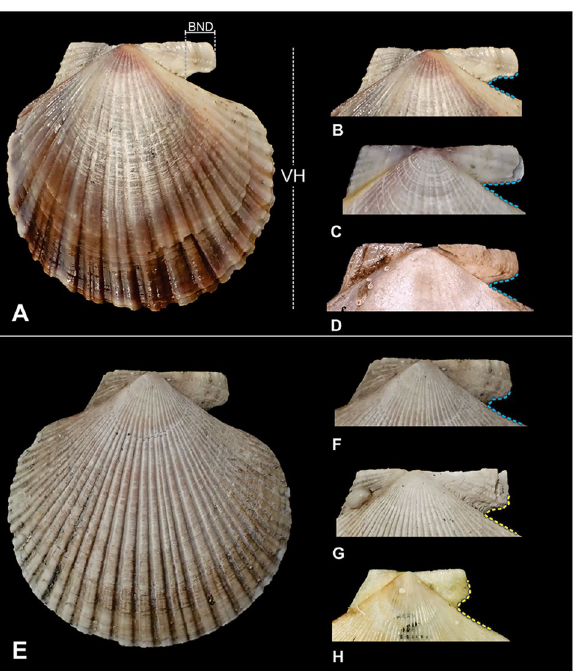
Figure 4. Linear measurements used in this study for the individuals of A. natan s and Z. patagonica . ( A – D ) A. natans and ( E – H ) Z. patagonica . VH = valve heights, BND = deep of the byssal notch. The dotted lines highlight the outline of the byssal notch, emphasizing whether it is acute (light blue) or arcuate